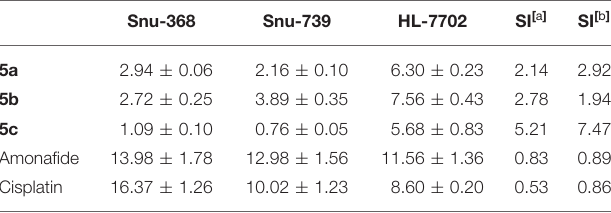
TABLE 2 | Inhibitory effect (IC 50 in µ M) of dinitro-naphthalimide conjugates 5a-5c , amonafide, and cisplatin on cancer cells Snu-368 and Snu-739 (hepatic carcinoma), and the matched normal cells HL-7702 (normal liver